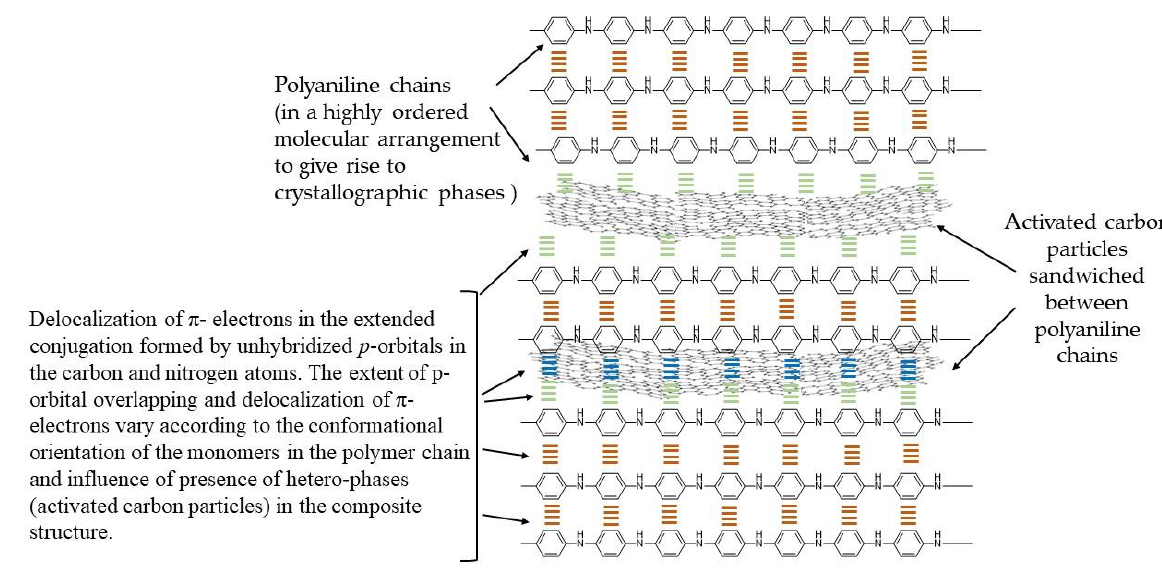
Figure 10. Polyaniline-activated carbon-sandwiched structure. The orderly arranged polyaniline chains give rise to well-defined crystallographic phases. The activated carbon particles are sandwiched between the long polymer chains.